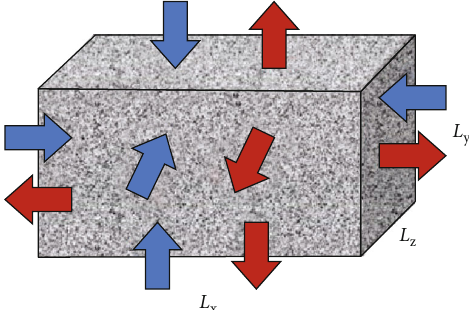
Figure 9: Three-dimensional water imbibition model (the blue arrows represent the water fl ow, and the red arrows represent the oil fl ow).